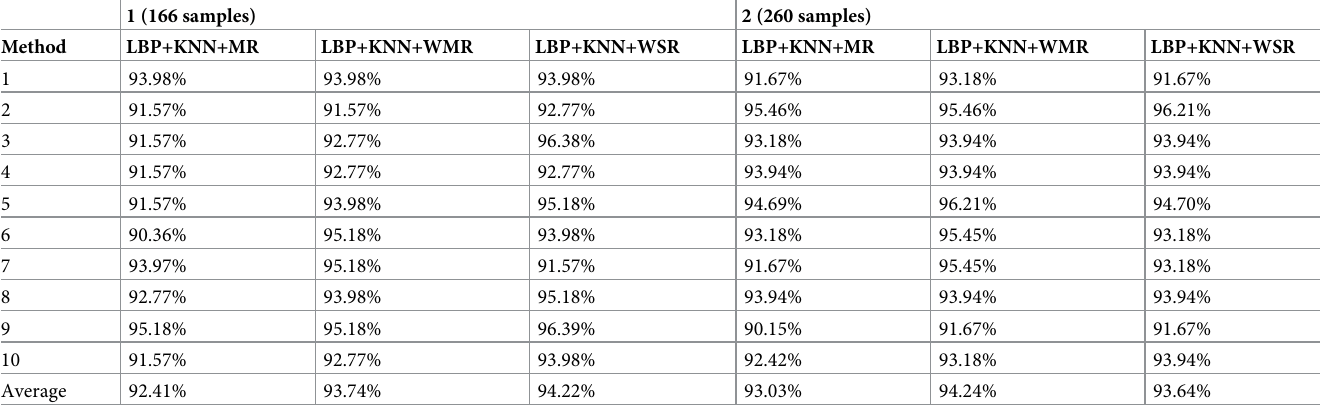
Table 8. Classification results using random training and testing